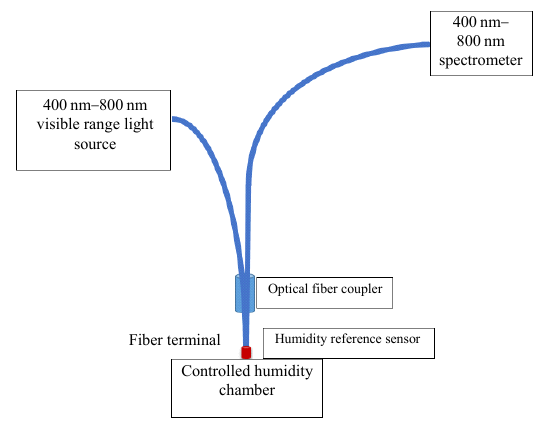
Fig. 6 Sensing setup for relative humidity